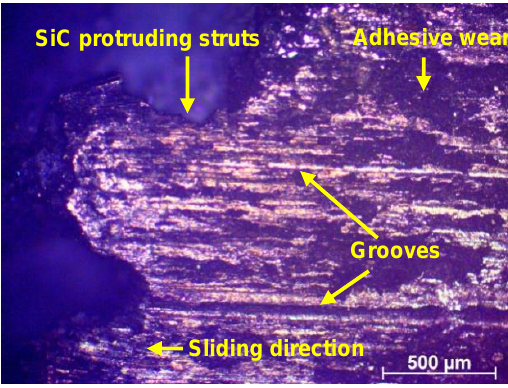
Figure 7. Optical micrograph of C4 composite exhibiting wear tracks at the Al-SiC interface.